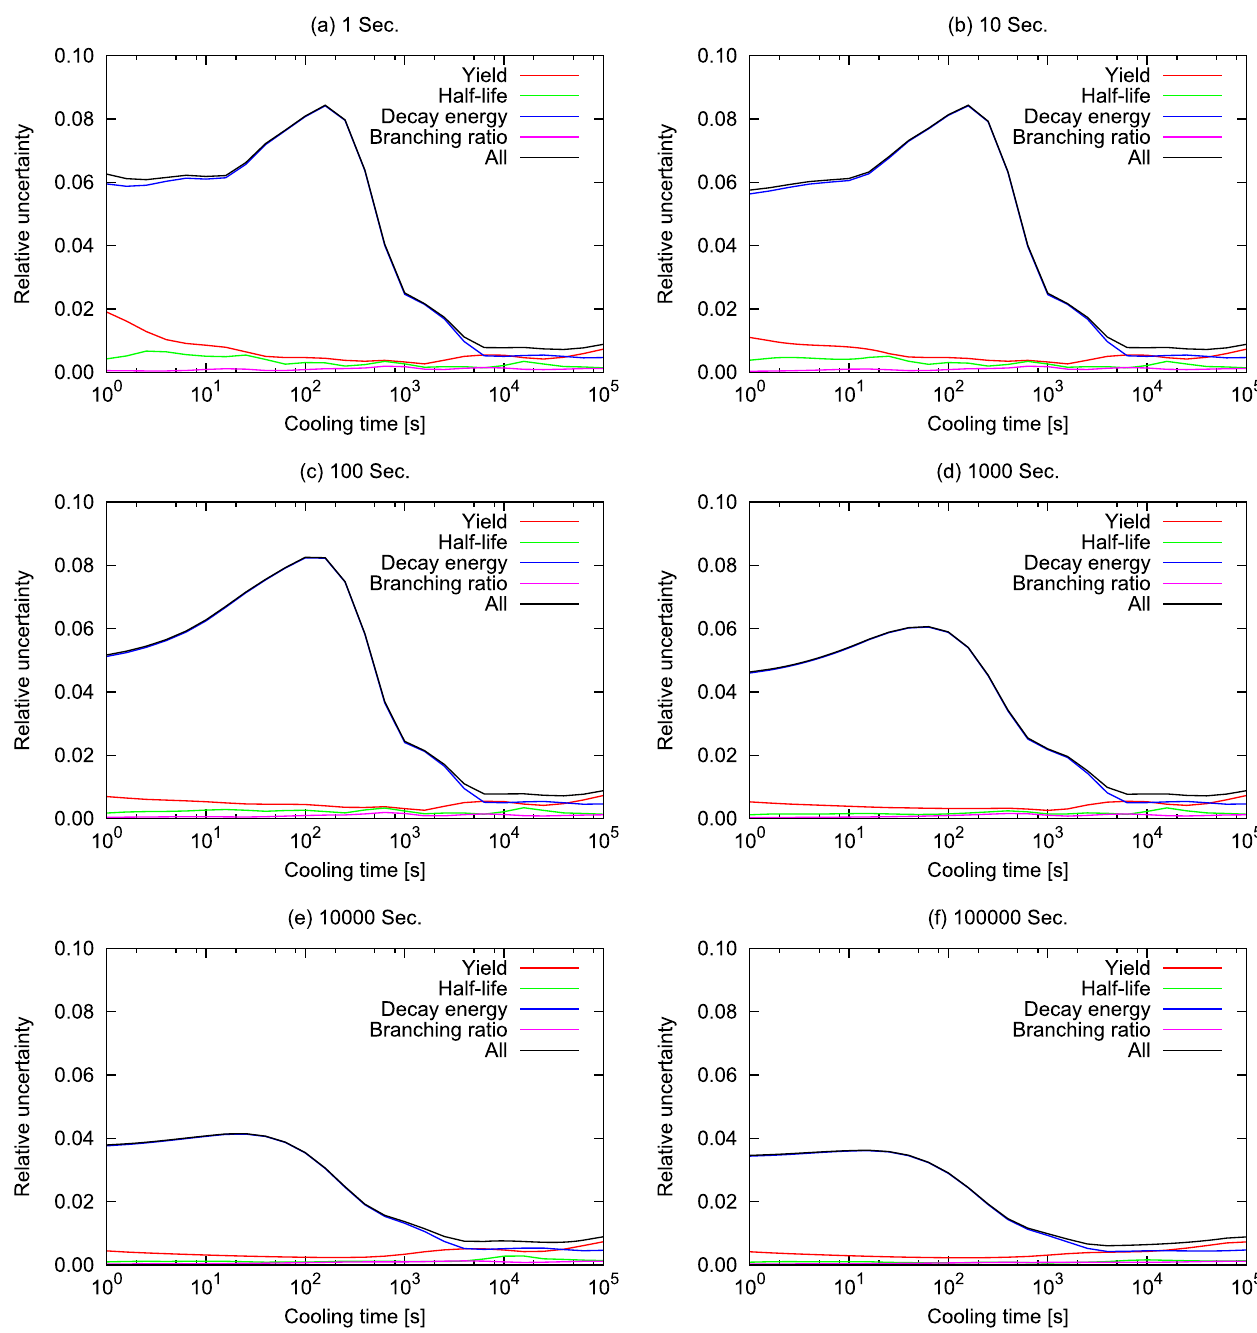
Fig. 6. Nuclear data-induced uncertainty of decay heat after uranium-235 fi ssion with thermal neutrons with different irradiation periods. Default uncertainty is assumed